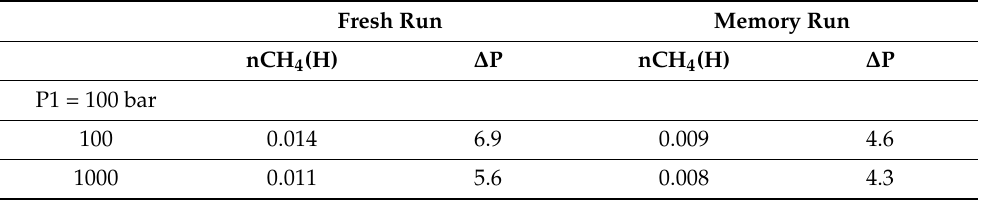
Table A6. Information on total gas uptake in hydrates and pressure drop observed during the fresh and memory run in the presence of L-histidine at five different concentrations. (P1 = Initial starting pressure, ∆ P = total pressure